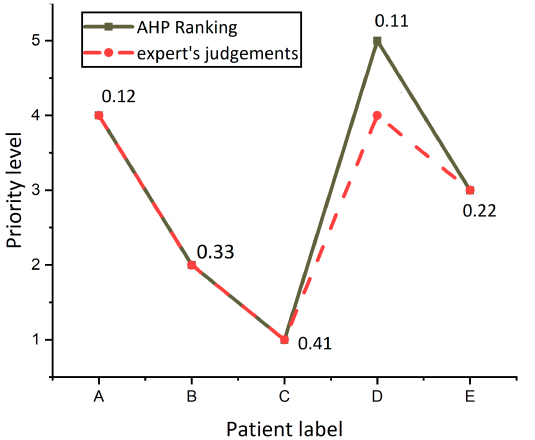
Figure 6. Differences in the patient’s prioritization for the AHP model and decision-making team.